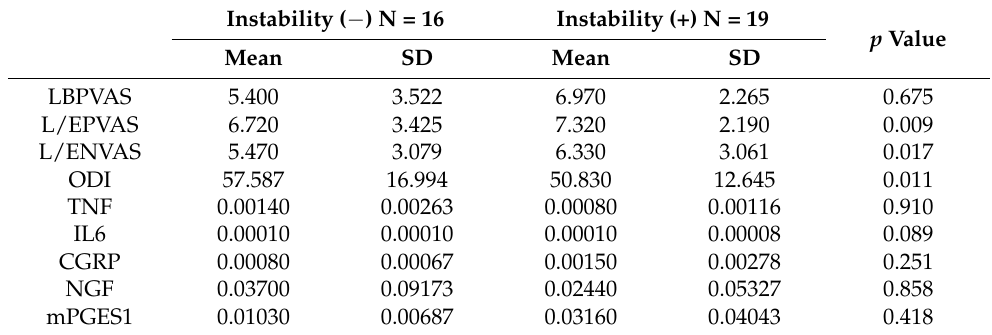
Table 2. Comparison of clinical findings and the expression of pain-related molecules between the spinal instability (+) and ( − )